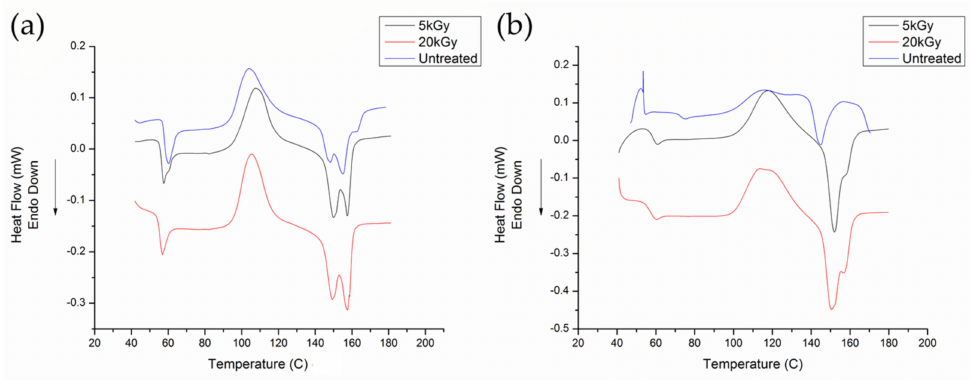
Figure 7. ( a ) Average cycle 1; ( b ) average cycle 2 for the unirradiated, 5 kGy, and 20 kGy